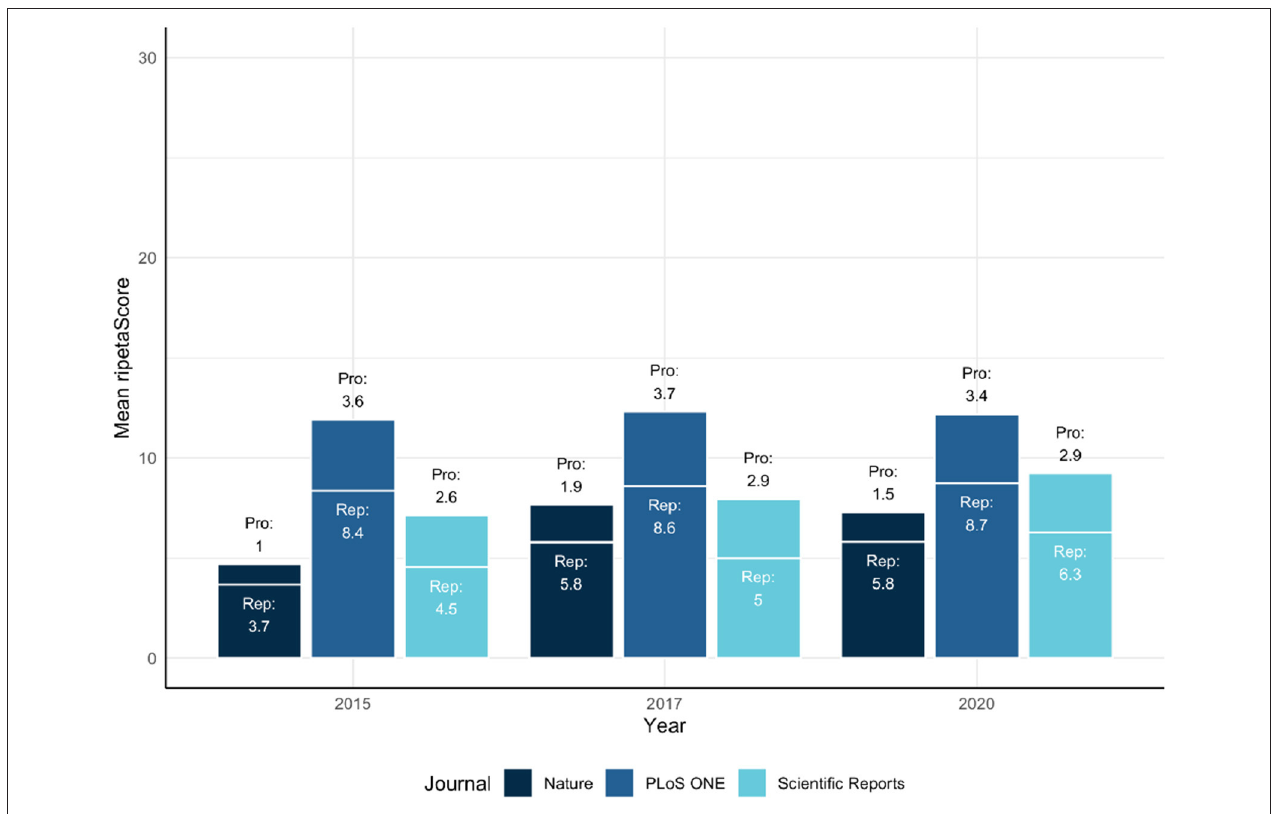
FIGURE 5 | Mean ripetaScore for Nature, Plos One, and Scientific